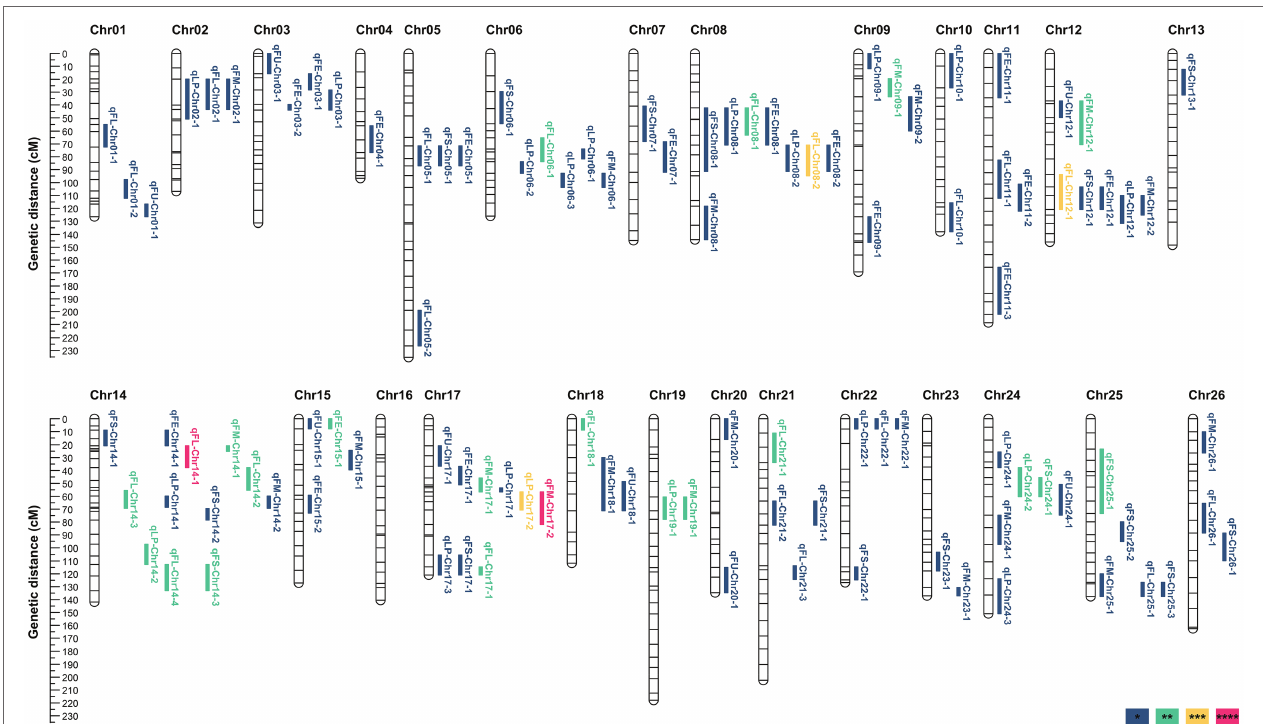
FIGURE 2 | QTL for lint percentage and fiber quality traits identified across four environments. *, **, ***, and **** indicate that QTL were detected in one environment, two environments, three environments, and four environments,